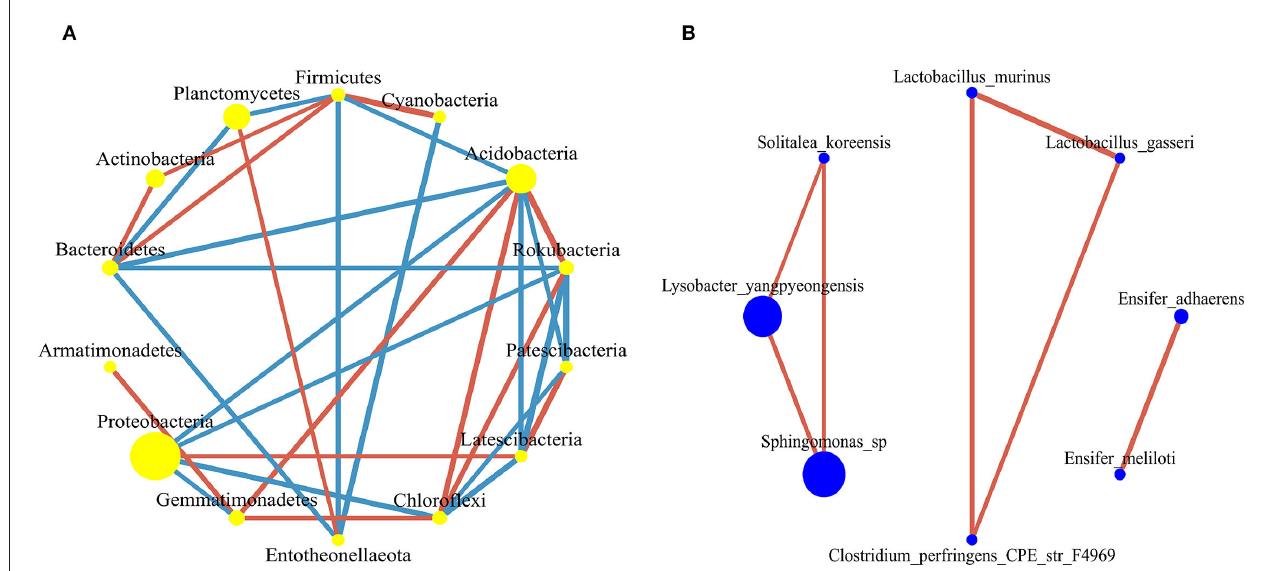
FIGURE 5 | The co-occurrence network of bacterial communities in forest gap sizes at the (A) phyla level and (B) species level. The nodes in the network represent 14 bacterial phyla and 8 bacterial species. The size of each node is proportional to the relative abundance. The red edge represents the positive correlation between bacteria, and the blue edge represents the negative correlation between